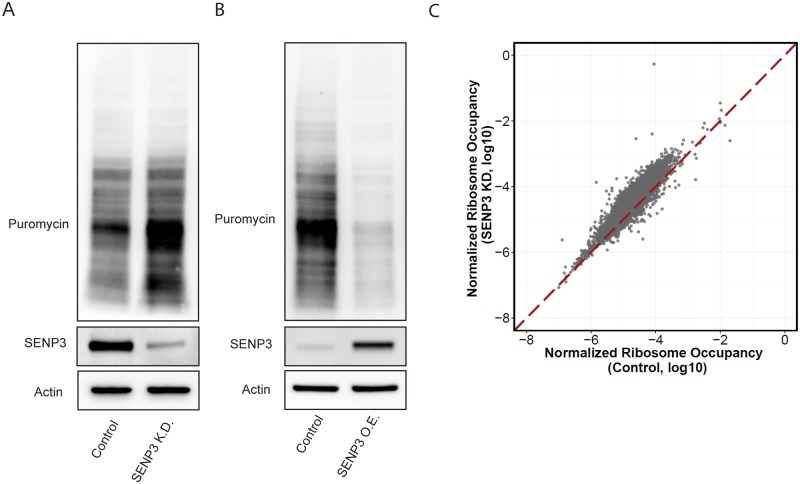
SENP3 silencing restores host protein translation.(A) Immunoblotting of puromycin-labelled newly-synthesized proteins in HepG2.215 control cells and HepG2.215 SENP3 K.D. cells. (B) Immunoblotting of puromycin-labelled newly-synthesized proteins in HepG2.215 control cells and HepG2.215 SENP3 O.E. cells. (C) Normalized ribosome occupancy in HepG2.215 control and HepG2.215 SENP3 K.D. cells.